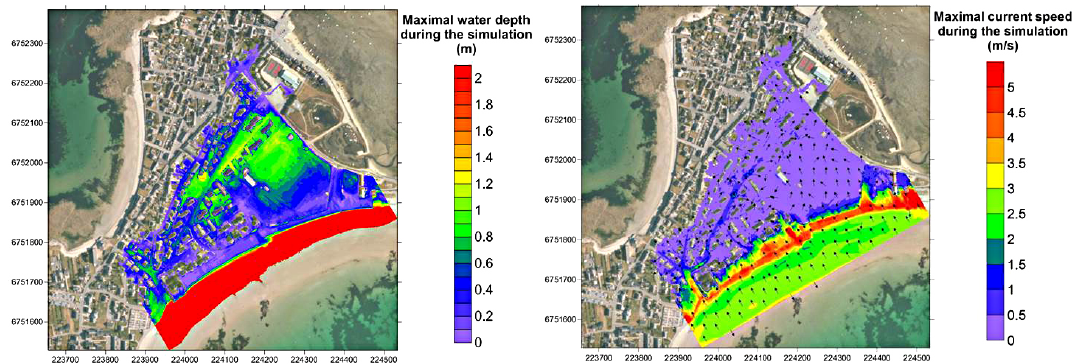
Figure 11. Maximum water depths (left) and currents (right) obtained inland during the SURF-WB simulation on the DEM (with explicit representation of the